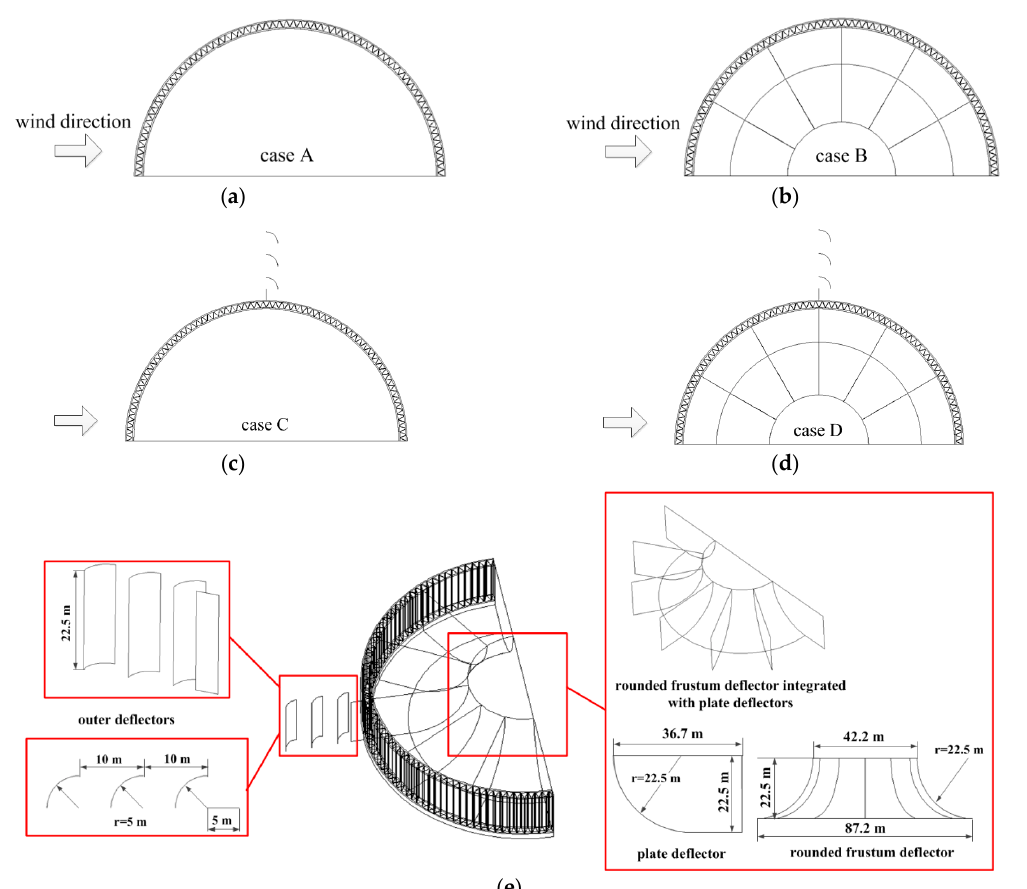
Figure 3. Schematics of combined air leading strategies. ( a ) Case A without air leading; ( b ) Case B with inner air leading baffles and rounded frustum; ( c ) Case C with outer air leading baffles; ( d ) Case D with both inner and outer air leading measures; ( e ) Geometric parameters.